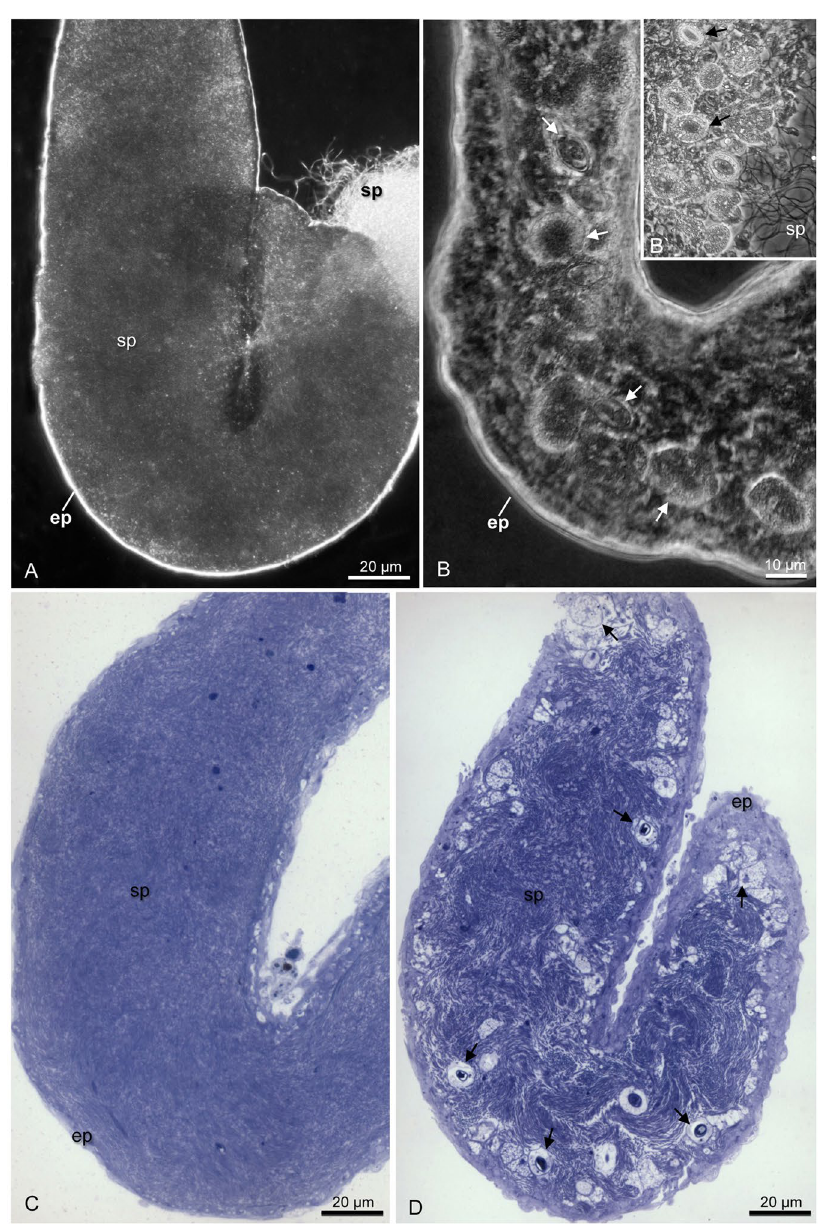
Figure 1. Photomicrographs of seminal vesicles of Tribolium castaneum in phase contrast (A,B,B’ ) and histological sections ( C,D ). ( A ) Uncontaminated seminal vesicle in total mount. Spermatozoa (sp); epithelium (ep). ( B,B’ ) Contaminated seminal vesicle in total mount. The arrows indicate the parasites. Note in ( B’ ) the large amount of parasites from seminal vesicle broken. ( C ) Histological section of uncontaminated seminal vesicle. Observe the lumen completely filled with only sperm (sp). ( D ) Histological section of contaminated seminal vesicle. Note the parasites in different stages (arrows) and located preferentially in the peripheral